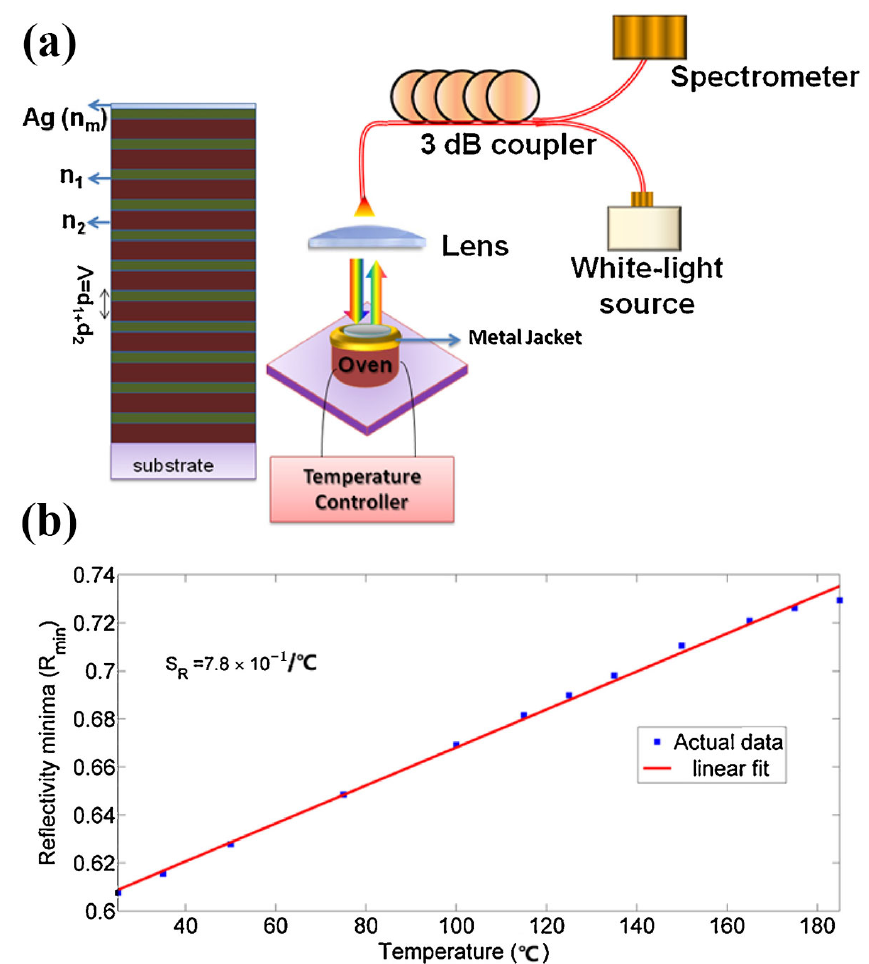
Figure 10. Construction and test result of the plasmonic temperature sensor based on Tamm-plasmon-polariton (TPP). ( a ) Typical metal-distributed-Bragg-reflector structure and the schematic diagram of excitation experiment device. ( b ) Graph of minimum reflectivity versus temperature sensed by temperature-sensor-based Tamm-plasmon-polariton. Reproduced with permission from reference [84]. Copyright 2017 Elsevier B.V.